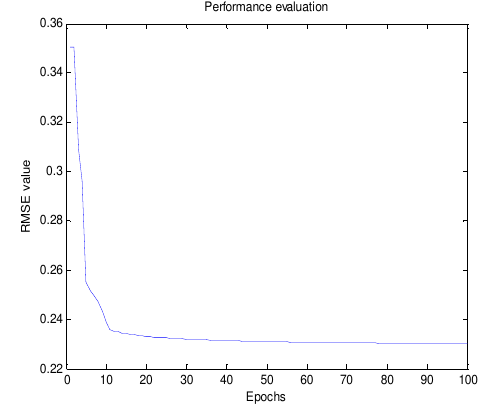
Figure 8. NFC training Performance for 3 features and 4